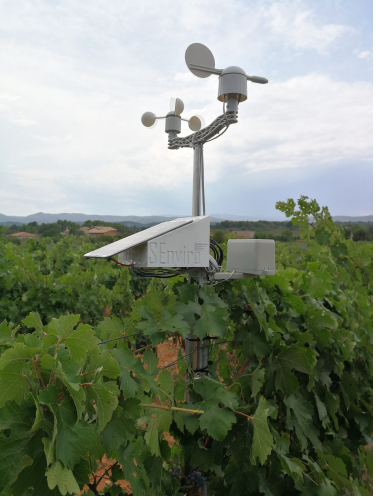
Figure 8. An example of SEnviro node deployed on a